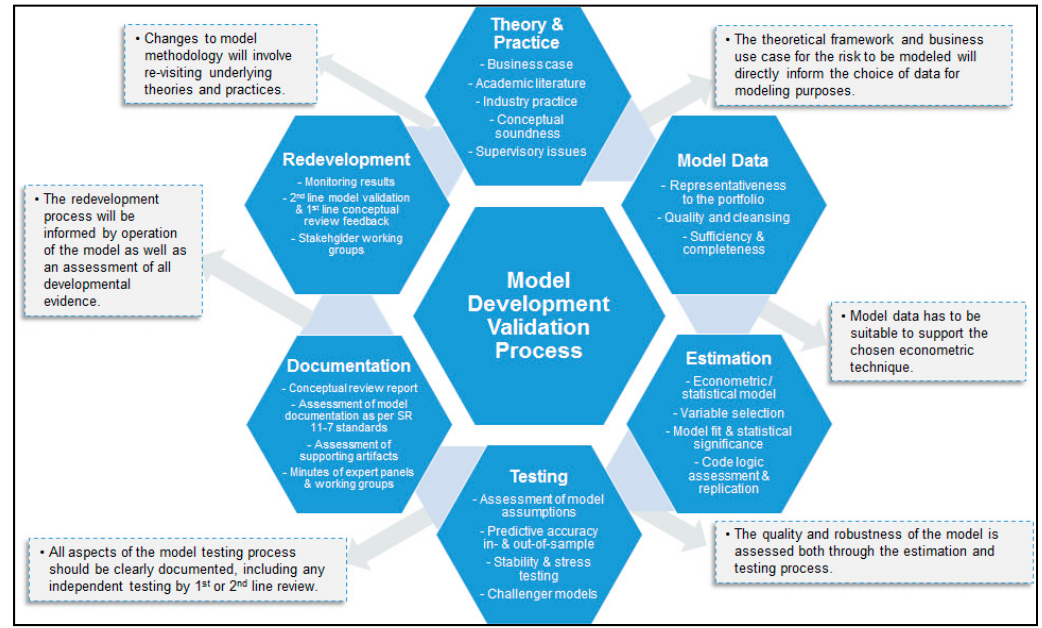
Figure 2. Overview of a general framework for the validation of model development—model data, estimation, conceptual review, and model estimation, conceptual review, and model testing.